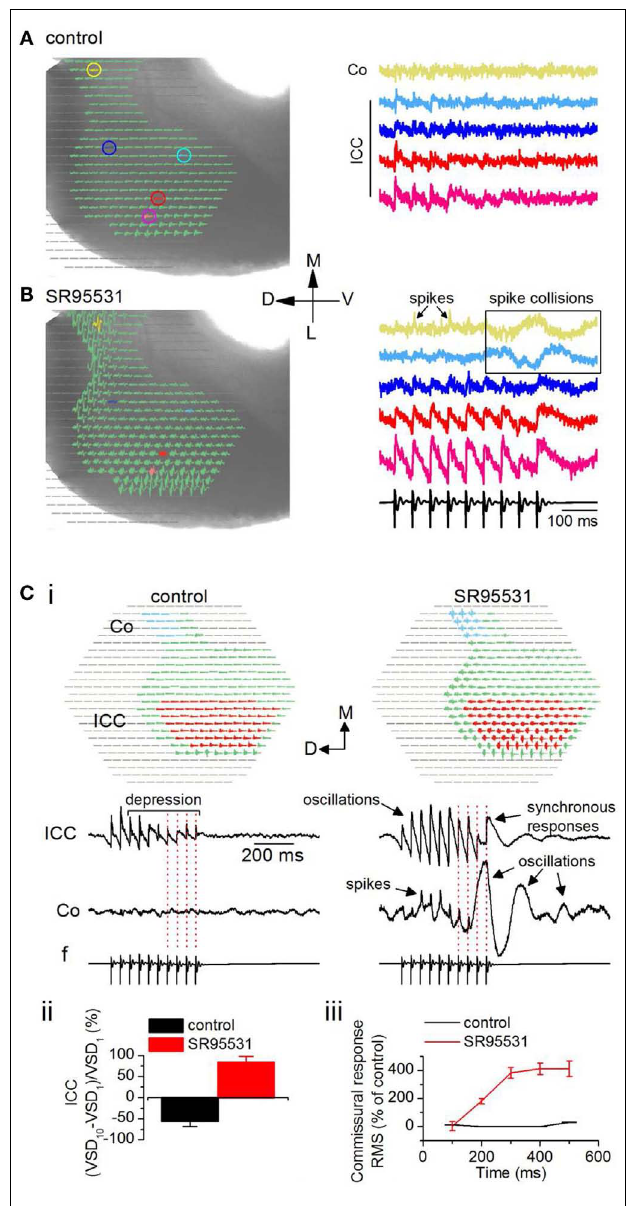
FIGURE 8 | Loss of inhibition promotes inter-collicular connectivity. Responses in a transverse IC slice (mouse, P18). (A) Normal ACSF. (B) SR95531 (an antagonist of GABA A receptors; 20 µ M). (A,B) Left panels, Diodes chosen to be displayed include the commissural region (yellow) through the lateral region of the ICC. Pixels at the lateral edge of the slice in the region of the external cortex have been omitted from the display. Right panels,Traces corresponding to the colored pixels in left panels.Traces are averages of eight trials in control and six in SR95531. Boxed region highlights non-linear activity profiles in the commissure. Co, commissure; ICC, IC central nucleus. (C) Effect of SR95531 on time-dependent changes in commissural activity during a 20Hz stimulus train. (i) Left panel, control; right panel, SR95531.Top, regions in the ICC and the commissural area (Co) over which responses are averaged. Bottom, Averaged responses illustrated as traces. f , field recording.Vertical dotted lines are aligned to the shocks in the field recording. (ii) Depression/facilitation index for responses in the ICC in control and SR95531.VSD 1 ,VSD 10 , responses to the first